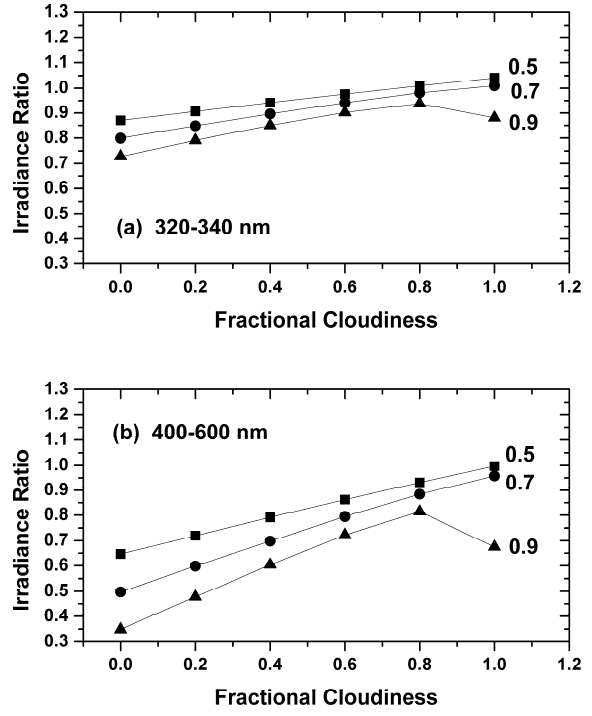
Fig. 10. Computed irradiance ratios as functions of fractional cloudiness for cloud albedos of A c = 0 . 5, 0 . 7 and 0 . 9. The solar disk is obscured by clouds, and the ground albedo is A G = 0 . 98. (a)